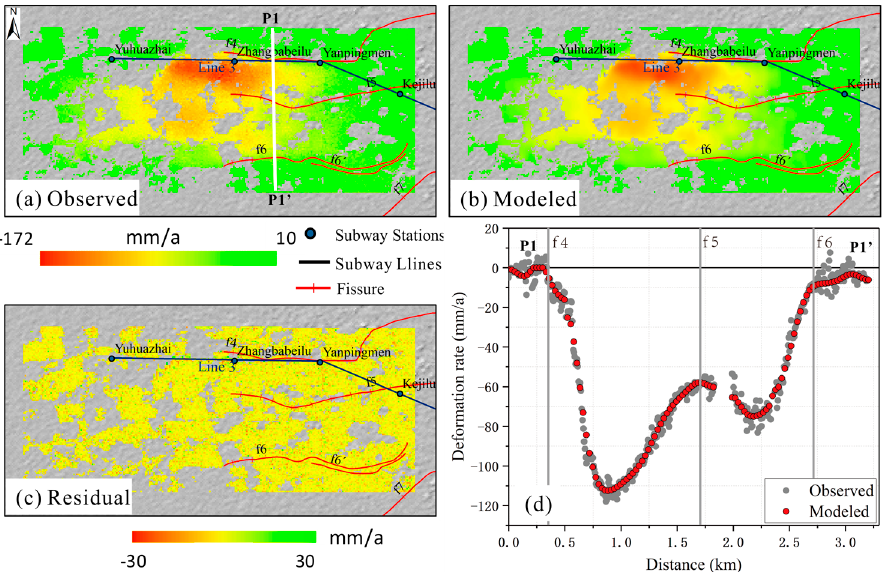
Figure 13. ( a ) The vertical deformation rate in 2017 over the YHZ subsidence bowl; ( b ) best-fitting model from a flat-lying distributed rectangle source in an elastic half-space; ( c ) residuals between the observed and modeled deformation; ( d ) deformation rate comparison between modeled and observed results along profile P1P1’.